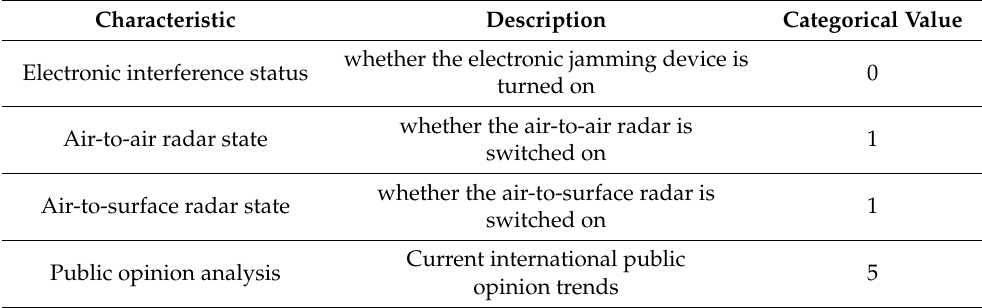
Table 2. Non-numerical air target intelligence